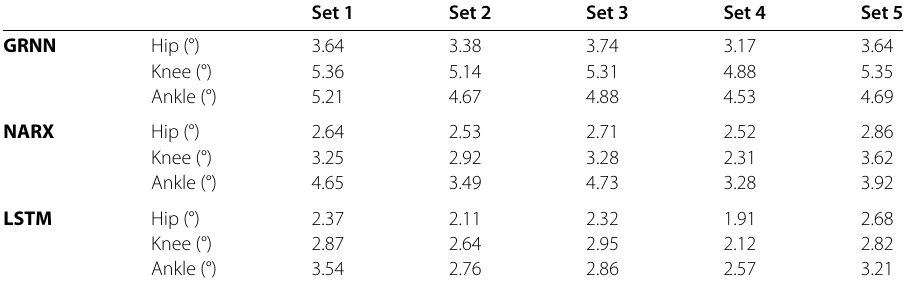
Table 3 Average RMSE performance comparison of the different neural networks and input sets Set 1 Set 2